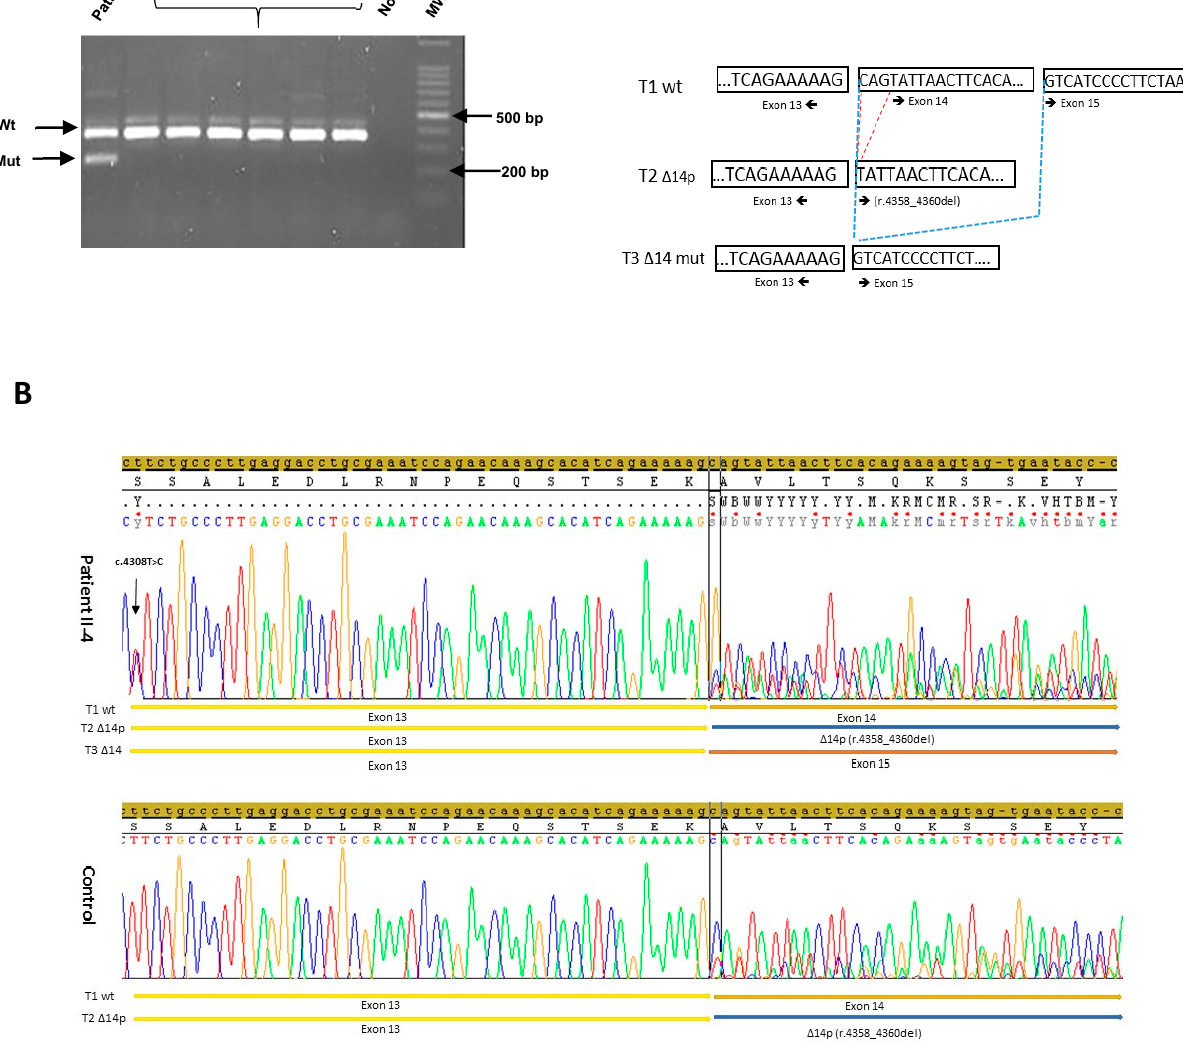
Figure 3. cDNA expression of the allele harboring the Alu insertion. ( A ) Agarose gel electrophoresis of the RT-PCR performed with mRNA obtained from patient II-4 and non-carrier controls. The exon 14 skipping ( ∆ 14) and wild type (WT) alleles are predicted to produce bands of 236 and 362 bp, respectively. ( B ) Sanger sequencing of the RT-PCR product of the sample from patient and non-carrier control. Physiological transcripts “T1 wt” and “T2 ∆ 14p” are present in both patient and non-carrier control and the aberrant transcript that led to exon 14 skipping (T3 ∆ 14) is present only in patient II-4 sample. The alternative spliced transcript ( ∆ 14p: r.4358_4360del) is observed physiologically at a rate of 40% [15]. The c.4308T > C single-nucleotide polymorphism present in the patient II-4 sample indicated that both alleles were amplified. ( C ) Schematic representation of the three transcripts observed in the patient II-4